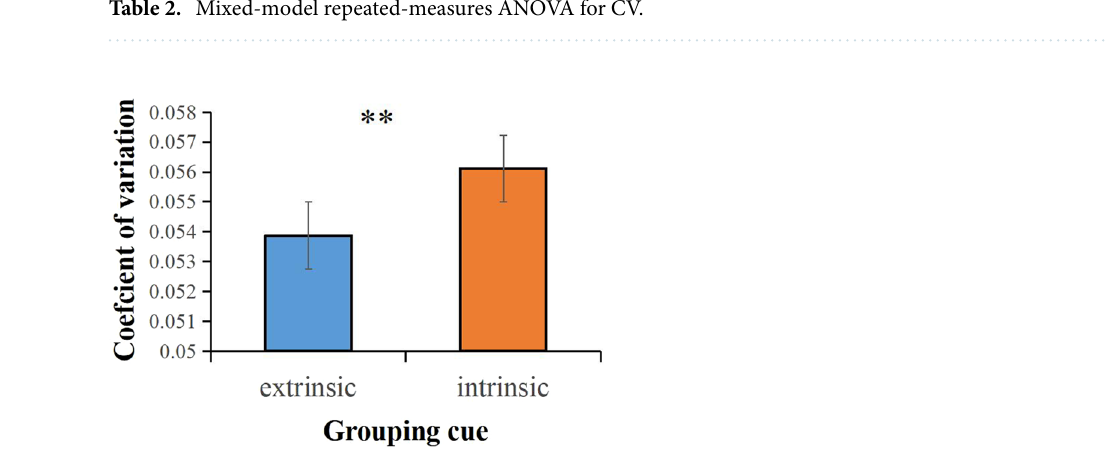
Table 2. Mixed-model repeated-measures ANOVA for CV.